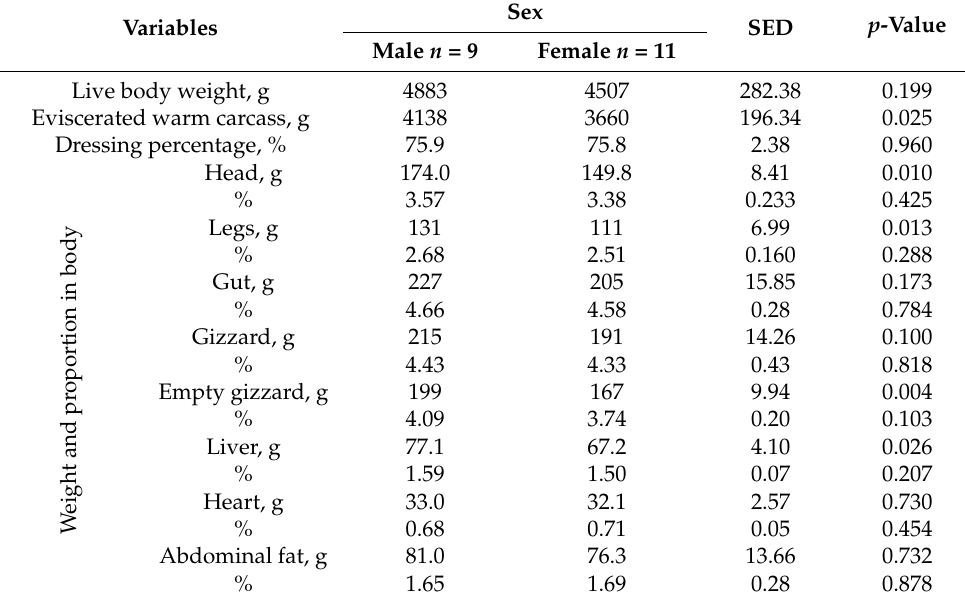
Table 2. Body composition of Vištin˙es geese.